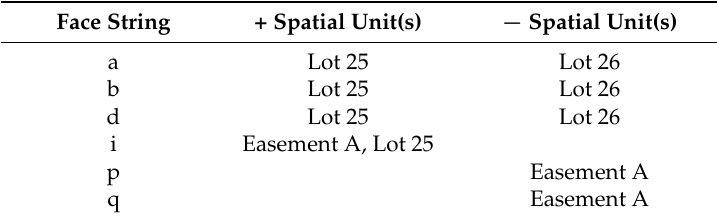
Table 1. Excerpt from Face Strings Table.